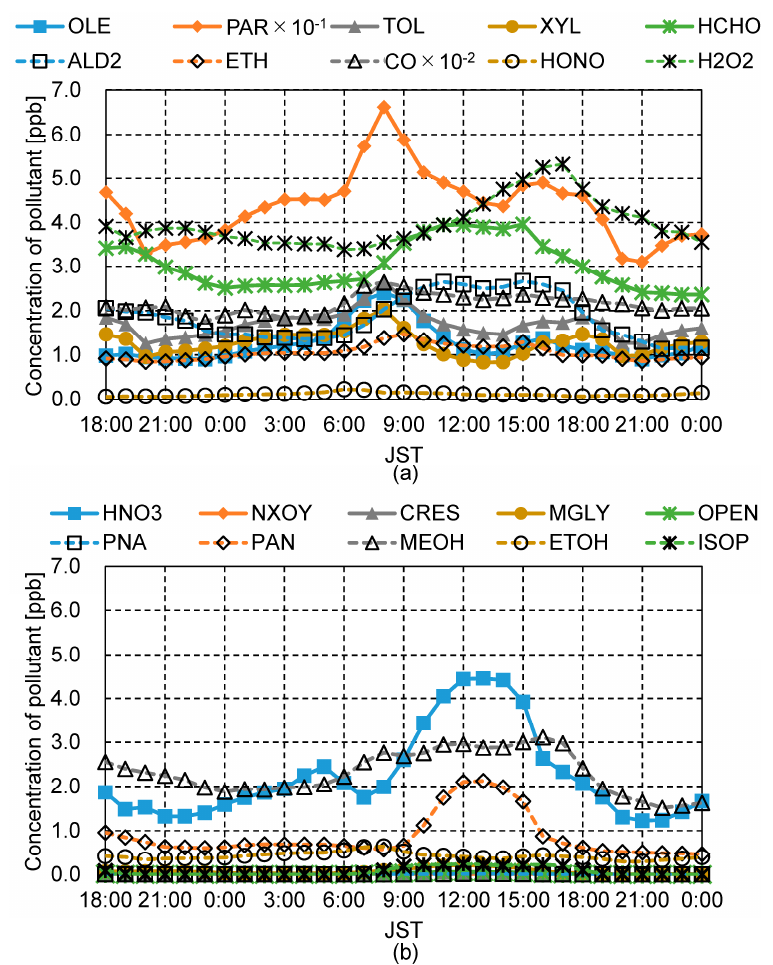
Figure A1. ( a , b )Diurnal variation of pollutants concentrations at a height of around 29 m (the center of the first layer of the WRF/CMAQ grids) from 18:00 on August 22 to 24:00 on 23 August 2010.